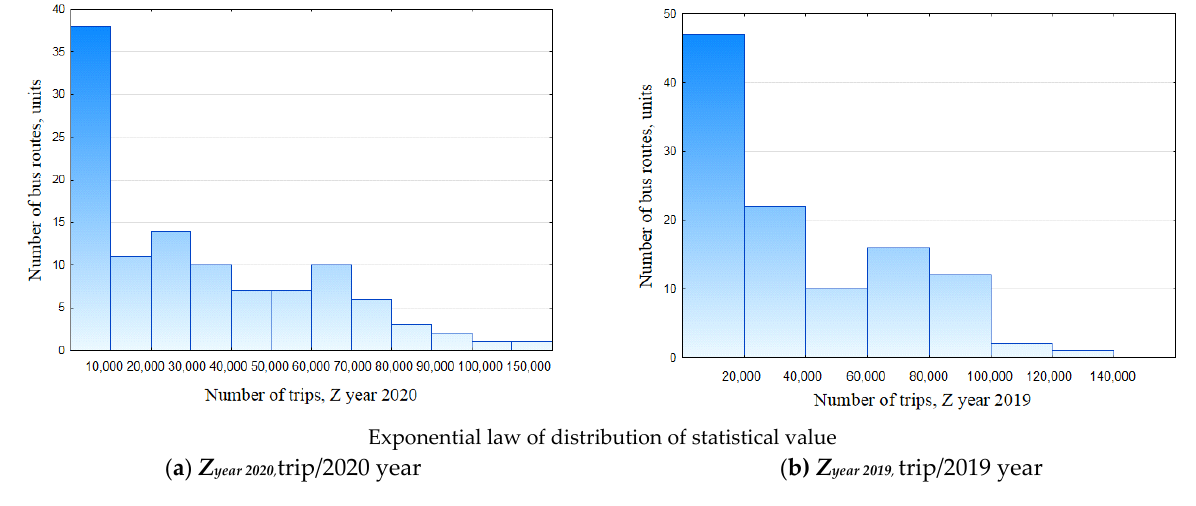
Figure 9. Distribution of values of the annual number of trips Z year on Tyumen CPPT bus routes in 2020 and 2019.